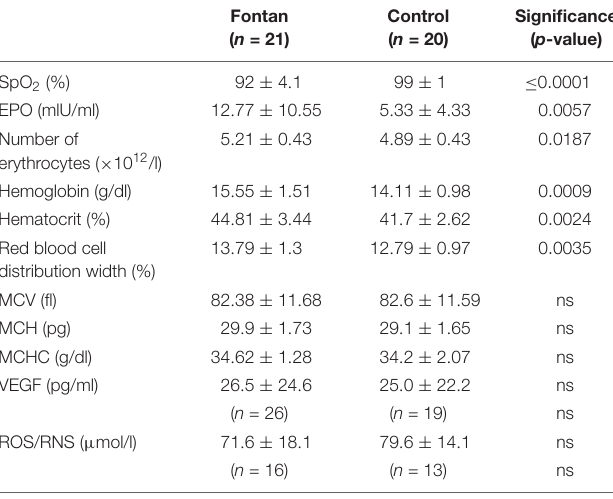
TABLE 3 | Blood count, SpO 2 , EPO, ROS/RNS, and VEGF at T0 in Fontan patients and controls.